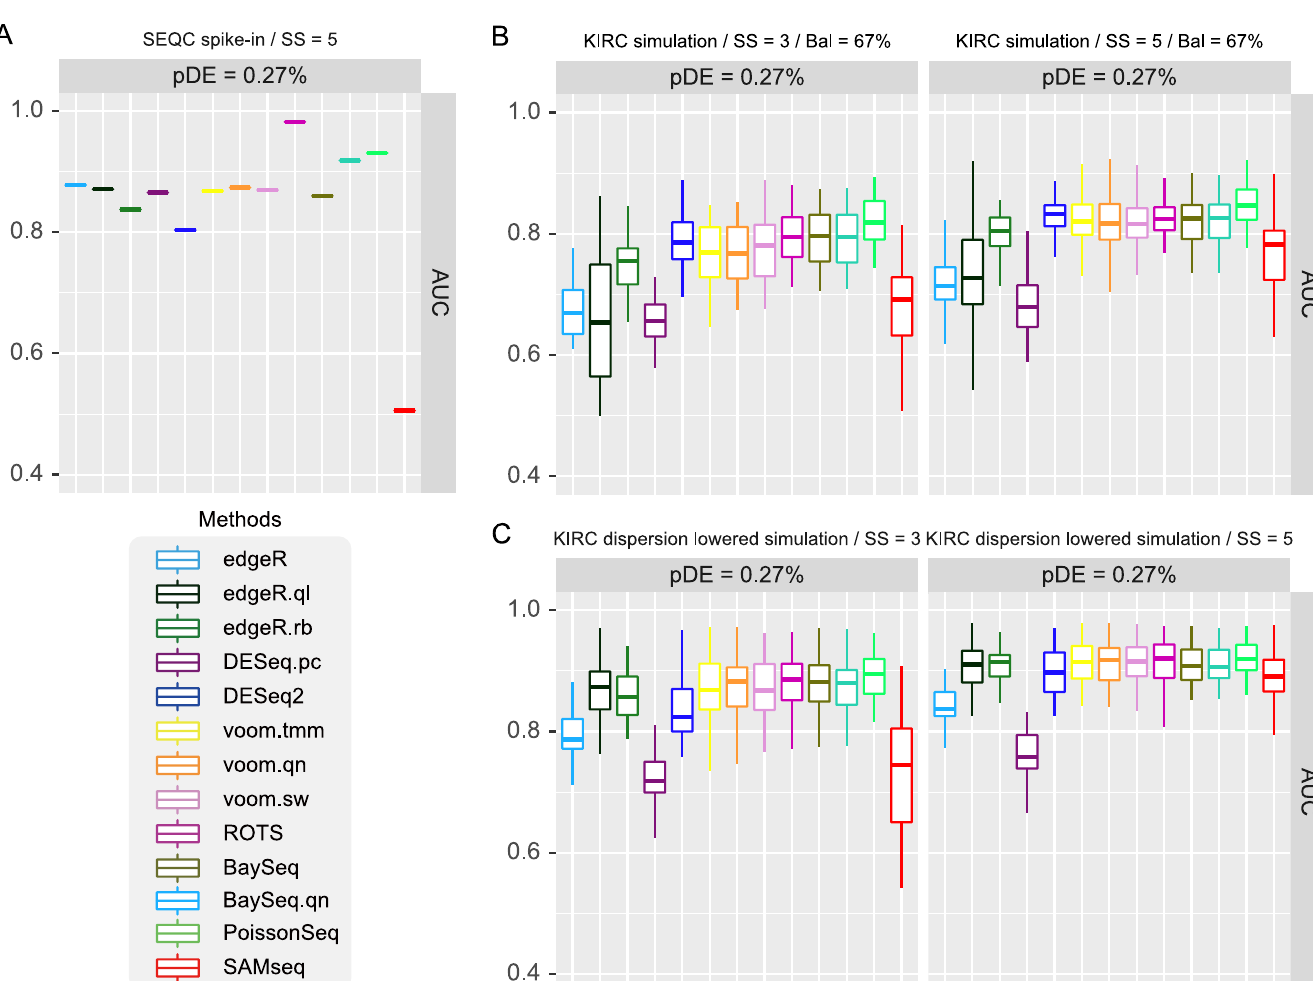
Fig 1. Performance comparison of 13 DE analysis methods for SEQC benchmark data and simulation data based on KIRC parameters. Three and five samples were used in simulation tests. (A) SEQC spike-in data test, 5 sample condition, 0.25, 1.5, 2 fold changes are introduced to DE genes. (B) KIRC based simulation. 1.5 or larger and 1.3 or larger fold changes are introduced to 0.27% of 10,000 genes for 3 and 5 samples, respectively. (C) Same condition as B but fixed fold changes, 0.625, 1.15, and 1.3 were introduced to DE genes. Dispersions were also lowered to SEQC level (22.5